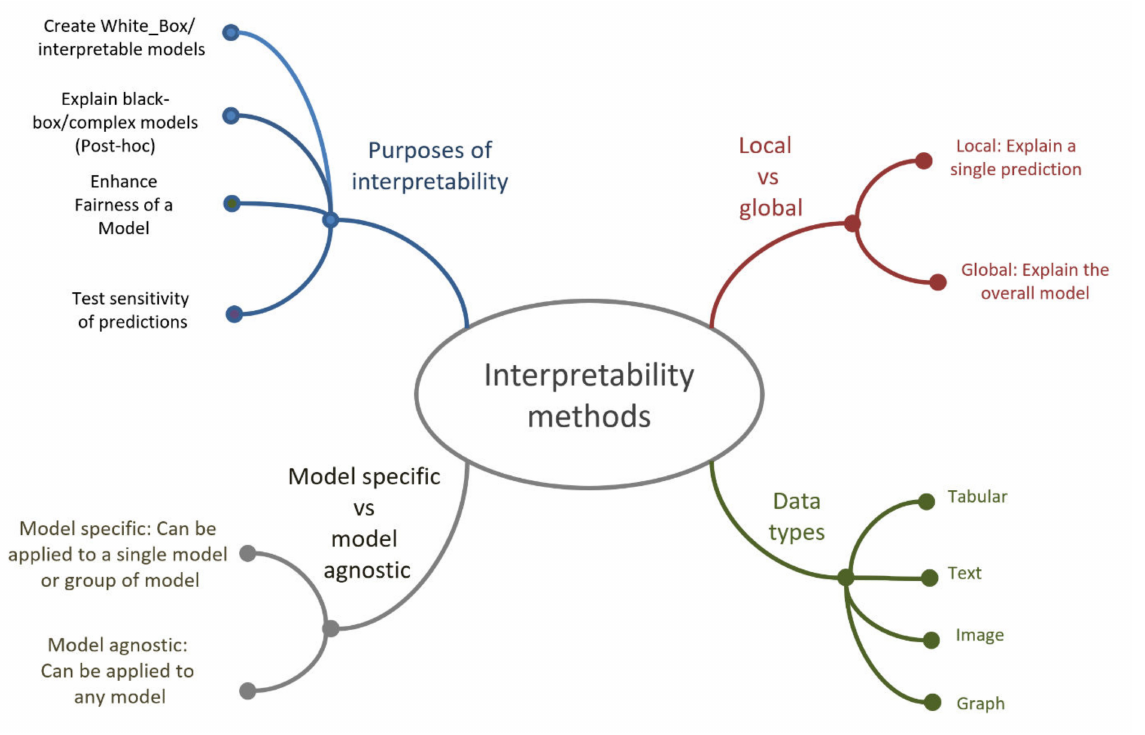
Figure 10. Classification of methods for interpreting machine learning. Source: generated by the